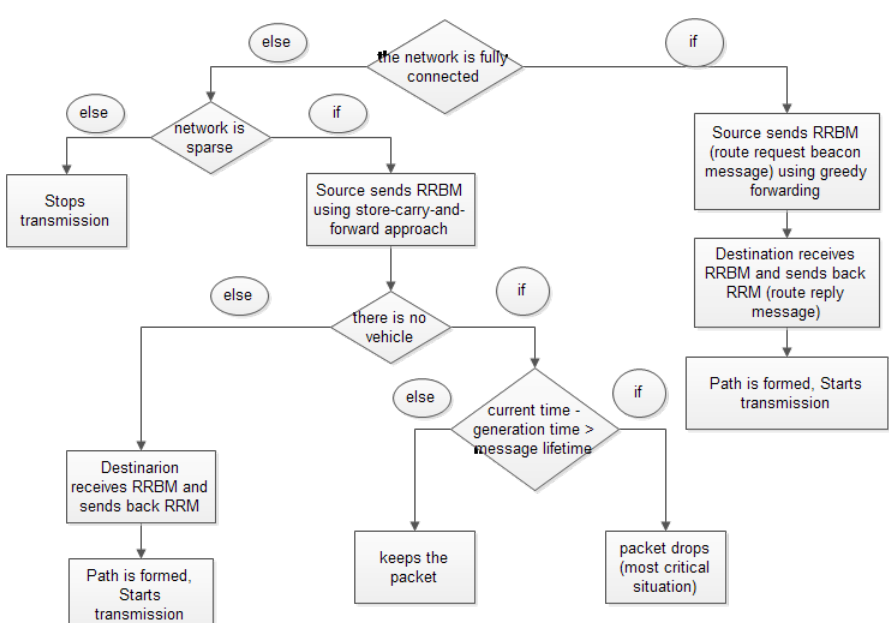
Figure 13. Workflow for anchor-based connectivity-aware routing (ACAR)